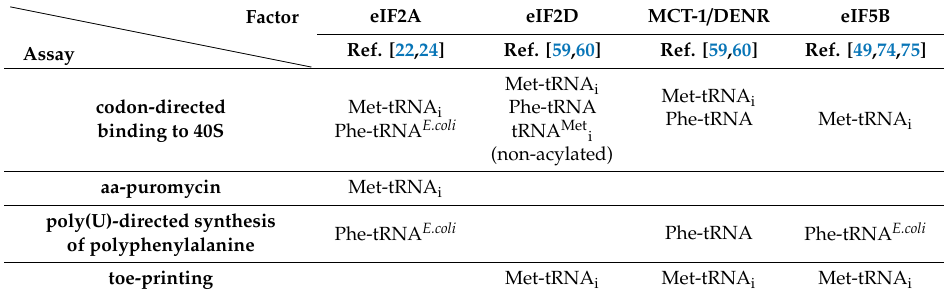
Table 2. tRNA binding properties of eIF2A (upon identification), eIF2D, MCT-1 / DENR and eIF5B. Factor eIF2A eIF2D Assay Met-tRNA i Met-tRNA i codon-directed Met-tRNA i Phe-tRNA Phe-tRNA binding to 40S Phe-tRNA E.coli tRNA Met i (non-acylated)